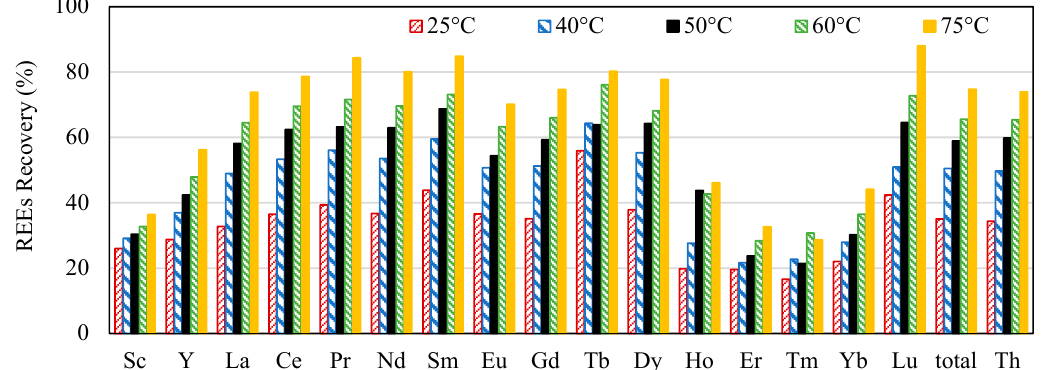
Figure 11. Effect of leaching reaction temperature on the leaching recovery of individual rare earth element (1 M H 2 SO 4 , 530 rpm, S / L = 10g / L, D 80 = 8.7 µ m, retention time of 120 min).